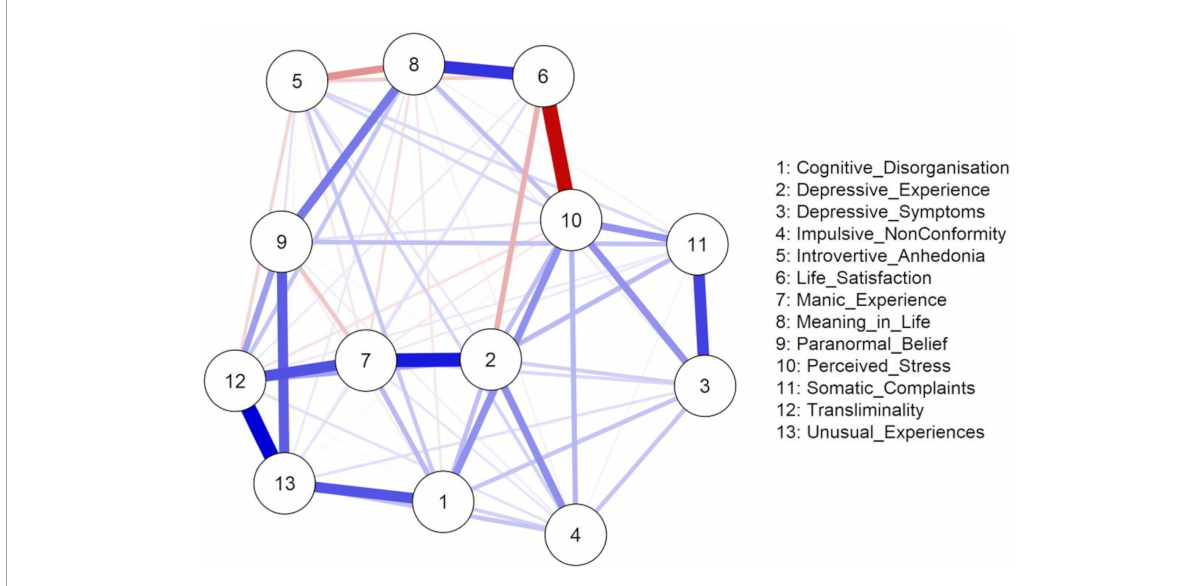
FIGURE1 EBICglasso model based on the network analysis of the relationships between Paranormal Belief, cognitive-perceptual factors, and well-being